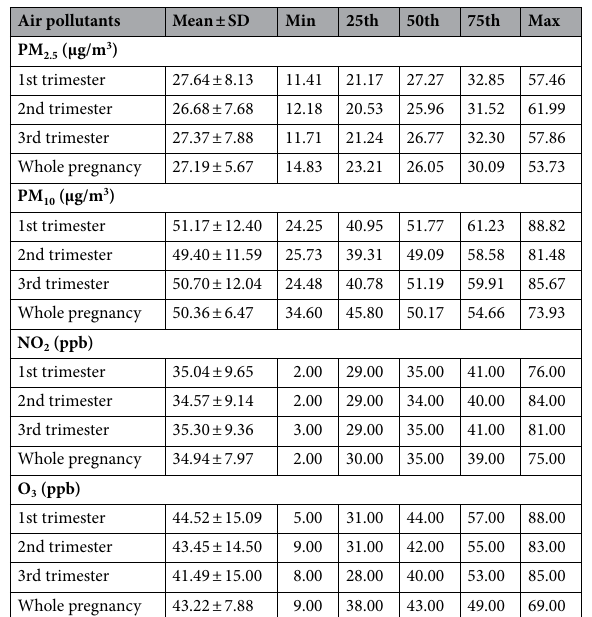
Table 2. Distributions of maternal air pollution exposure levels for different pregnancy periods. SD standard deviation, ppb parts per billion.